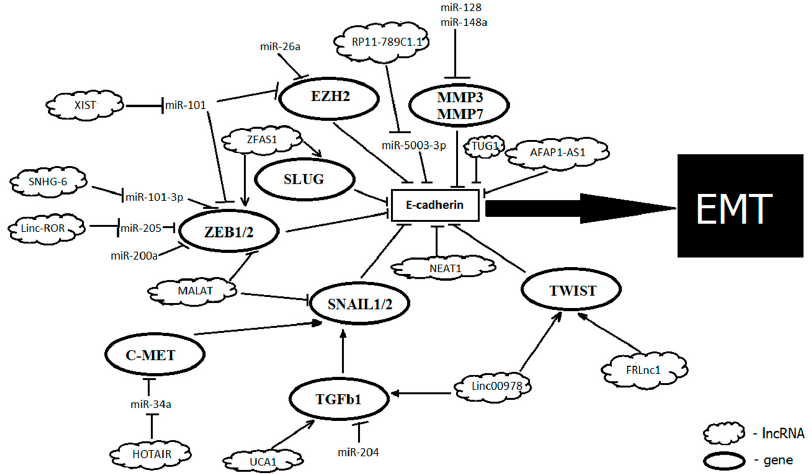
Figure 1. Noncoding RNAs that facilitate the epithelial–mesenchymal transition (EMT) in Gastric cancer (GC) by acting on E-cadherin.